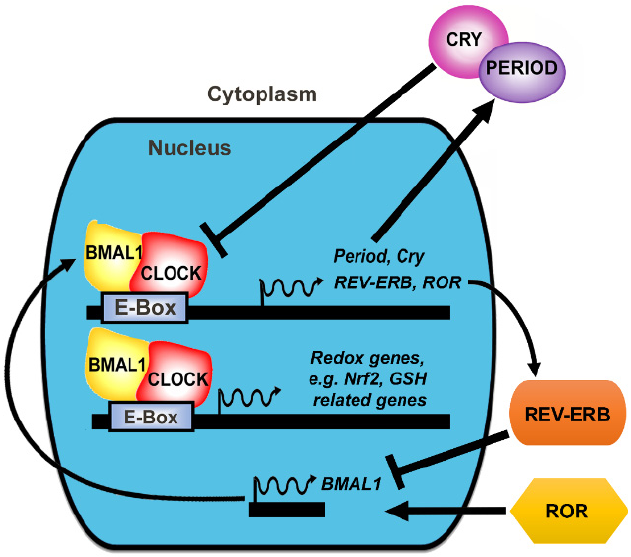
Figure 2. The transcriptional-translational feedback loop. At the molecular level, circadian rhythms are generated by the rhythmic expression of clock genes and the proteins they encode. CLOCK and BMAL1 heterodimers activate transcription of period (Per) and cryptochrome (Cry) genes. PER and CRY proteins, in turn, inhibit their own expression by repressing CLOCK/BMAL1 activity. BMAL1/CLOCK also controls the rhythmic expression of REV-ERB α , which feeds back to suppress BMAL1 transcription. The expression of retinoic acid-related orphan receptor (ROR α ) is also con- trolled by BMAL1/CLOCK, which feeds back to activate BMAL1 transcription. BMAL1/CLOCK also activates the transcription of clock-controlled genes such as Nrf2- and GSH-related genes. This feedback loop generates ~24 h oscillations of clock protein levels and activity, which is translated into circadian control of behaviour and physiology.